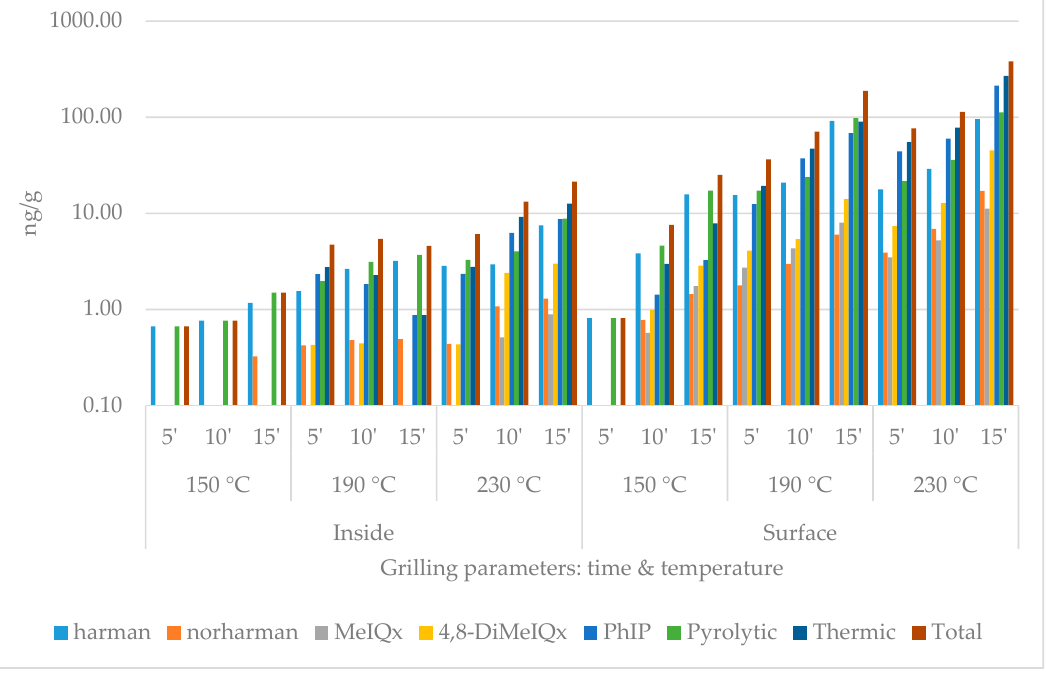
Figure 3. Heterocyclic amine content of chicken breast without skin grilled with opened top plate. (logarithmic scale).